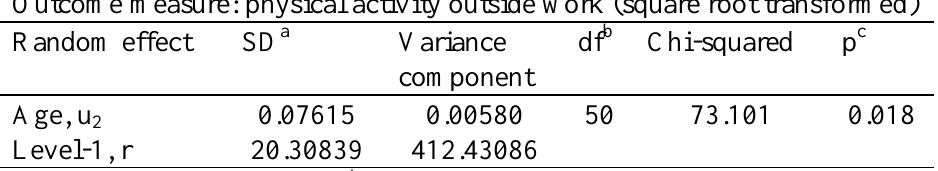
Table 7. Summary of random effects for the multi-level model for activity outside work. Outcome measure: physical activity outside work (square root